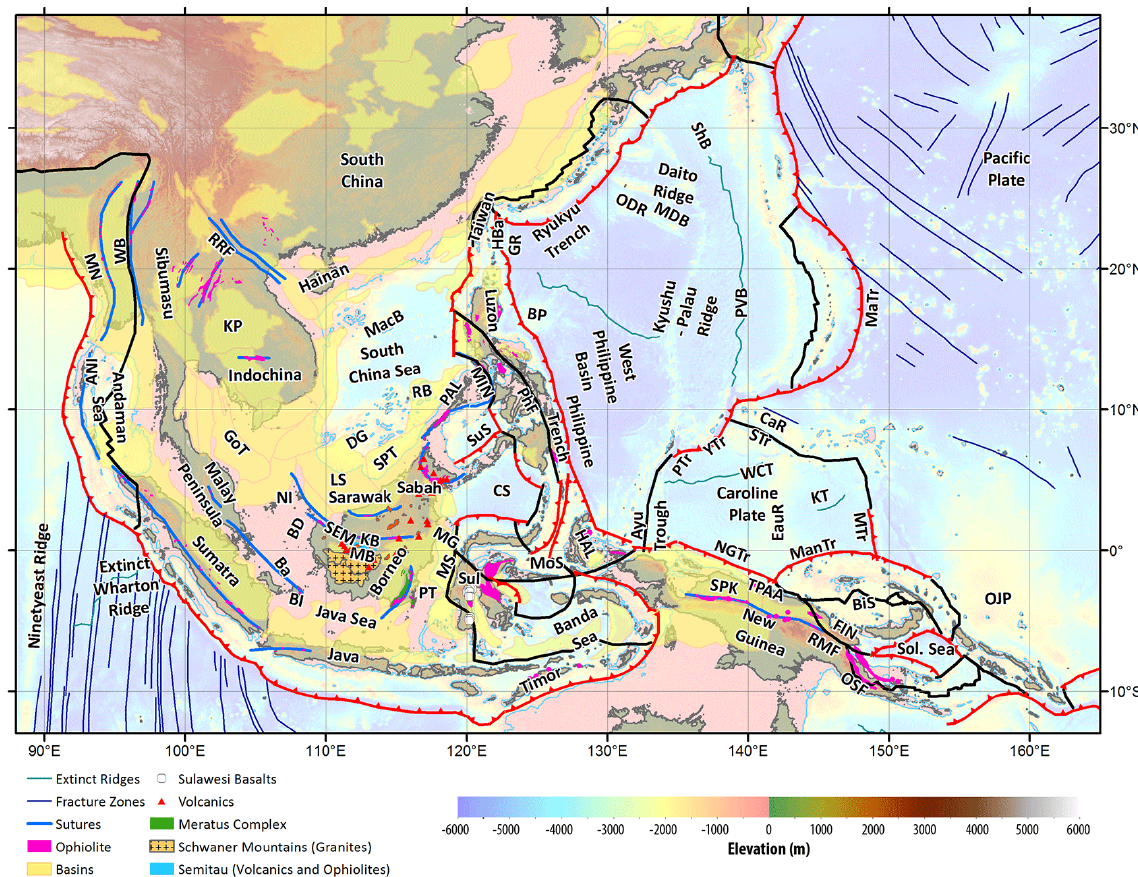
Fig. 1a. Regional tectonic setting with plate boundaries (MORs/transforms= black, subduction zones=teethed red) from Bird (2003) and ophiolite belts representing sutures modified from Hutchison (1975) and Baldwin et al. (2012). West Sulawesi basalts are from Polvé et al. (1997), fracture zones are from Matthews et al. (2011) and basin outlines are from Hearn et al. (2003). ANI–Andaman and